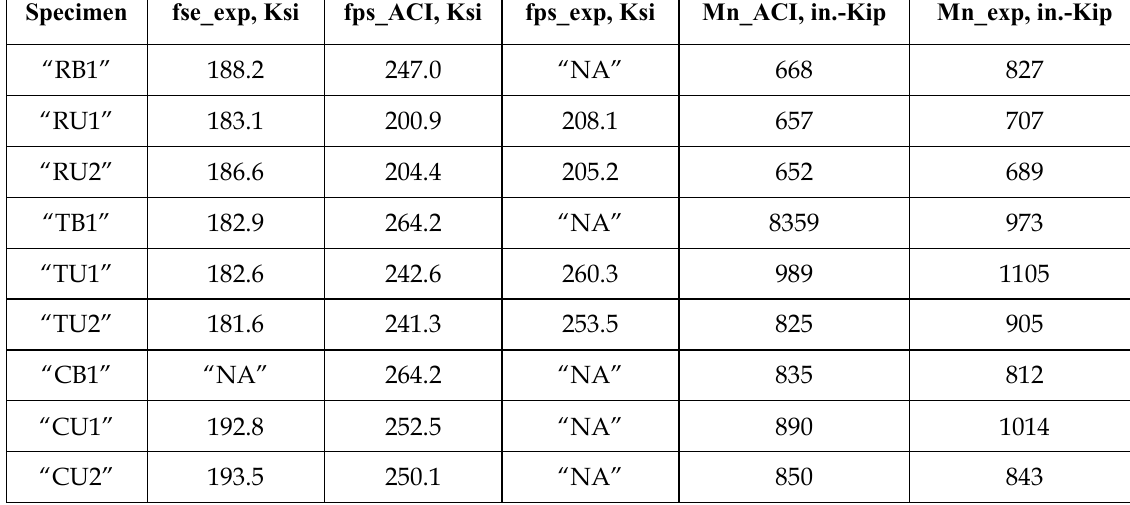
Ultimate moment strength for beams examined by Mattock et al.